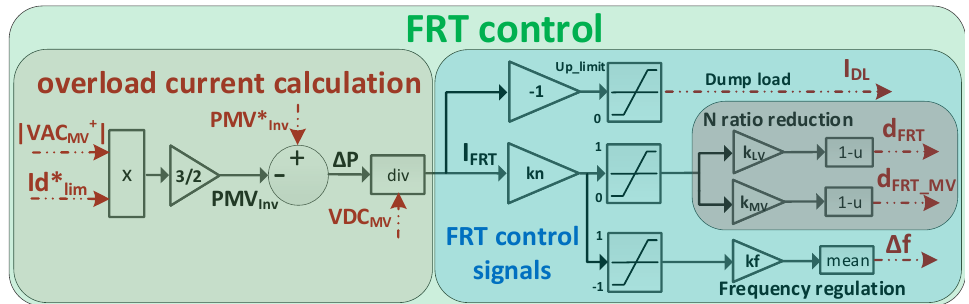
Figure 15. Block diagram of the proposed Fault-Ride-Through control